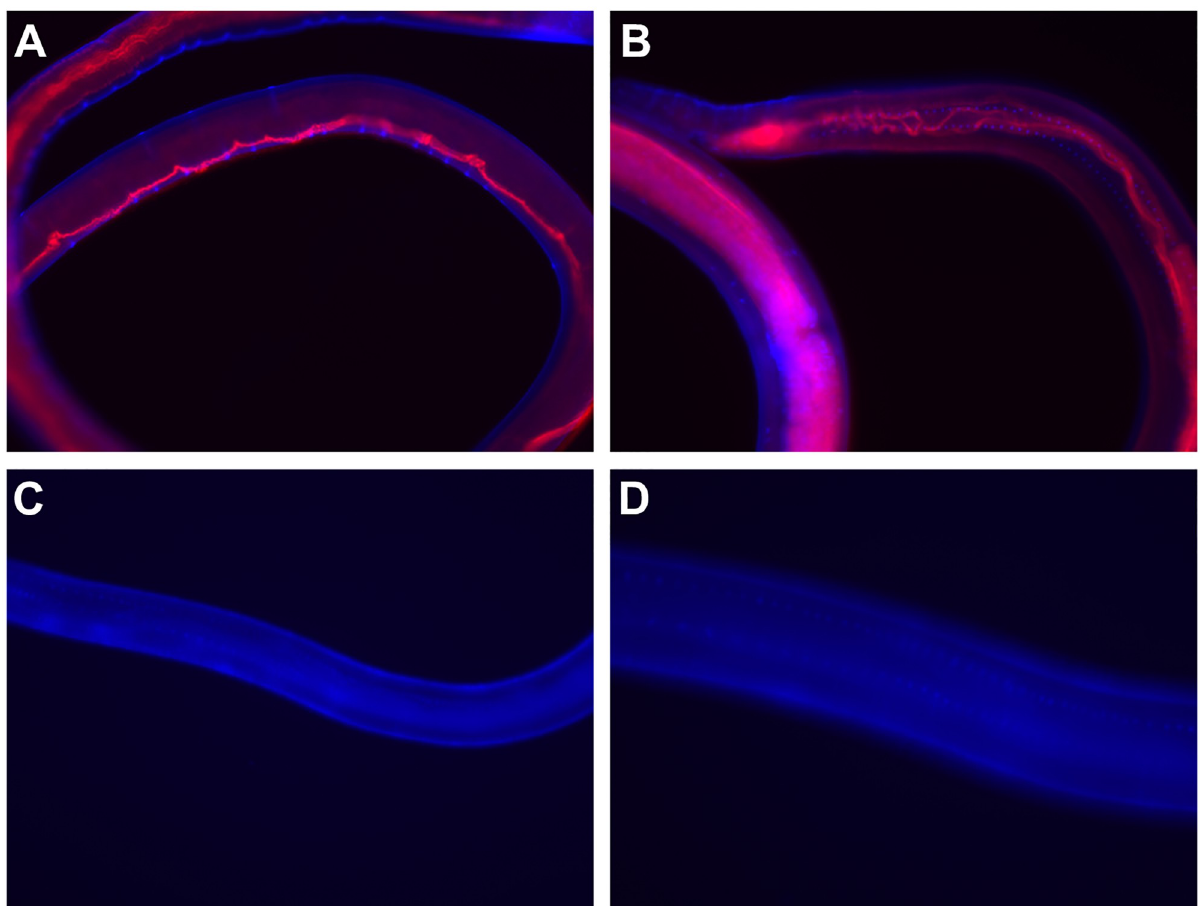
Fig 3. Cy3-labeled Bm-UGT siRNA enters the intestinal tracts of female B malayi adult worms. B . malayi adult worms incubated with Cy3-labeled siRNA (red) for 24 hrs and visualized at magnifications of (A) 100x and (B) 200x. Worms incubated in media alone for 24 hrs and visualized at magnifications of (C) 100x and (D) 200x. Worms were counterstained with DAPI (blue).